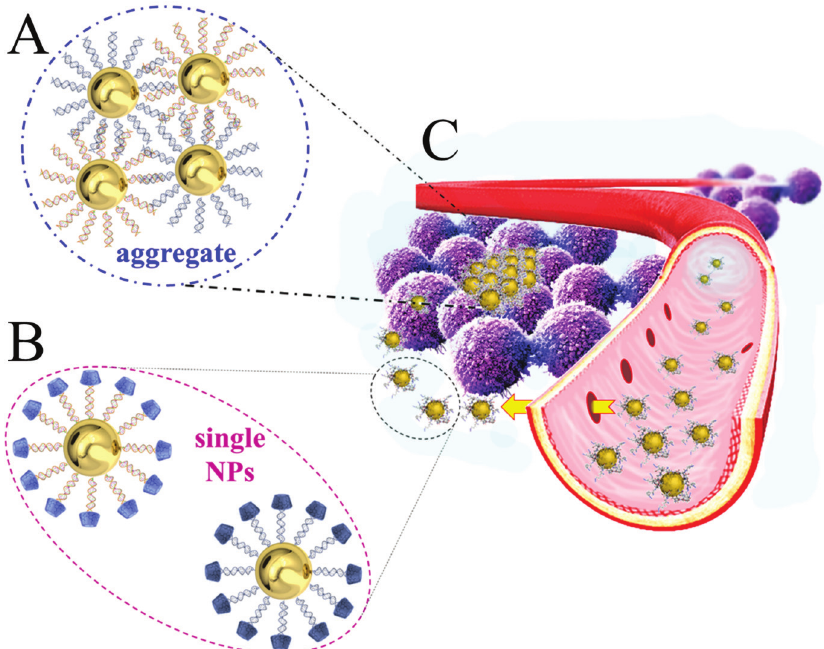
Figure 5. Schematic illustration of: ( A ) aggregate formation of gold nanoparticles coated with complementary ss DNA strands; ( B ) single dispersed gold nanoparticles coated with ss DNA strands and protected with alpha-cyclodextrin to avoid aggregation; and ( C ) tumor-specific photoacoustic imaging and photothermal